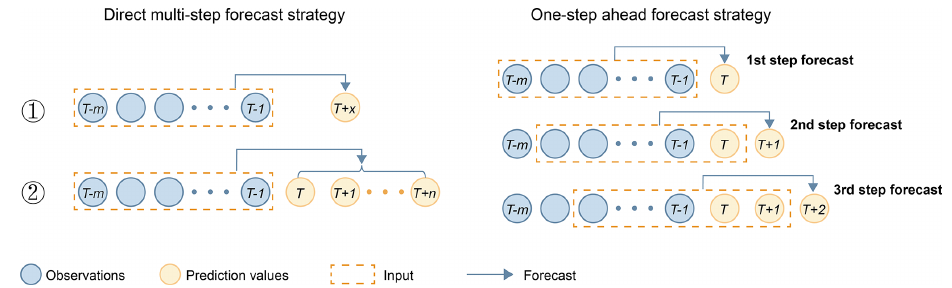
Figure 2. Two main strategies of multistep forecasting for ENSO prediction: direct multistep forecast strategy and one-step-ahead forecast strategy. The direct multistep forecast strategy has two methods, the second of which is used in this